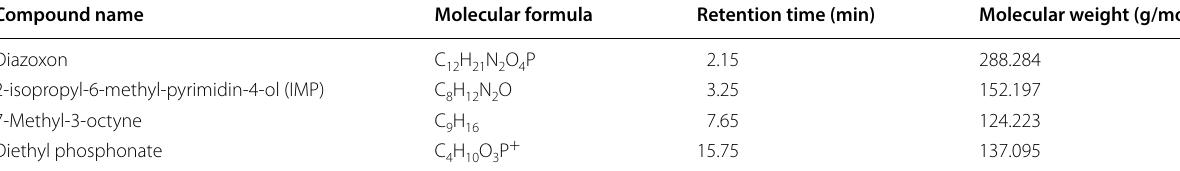
Table 6 The characteristics of by-products identification due to diazinon decomposition